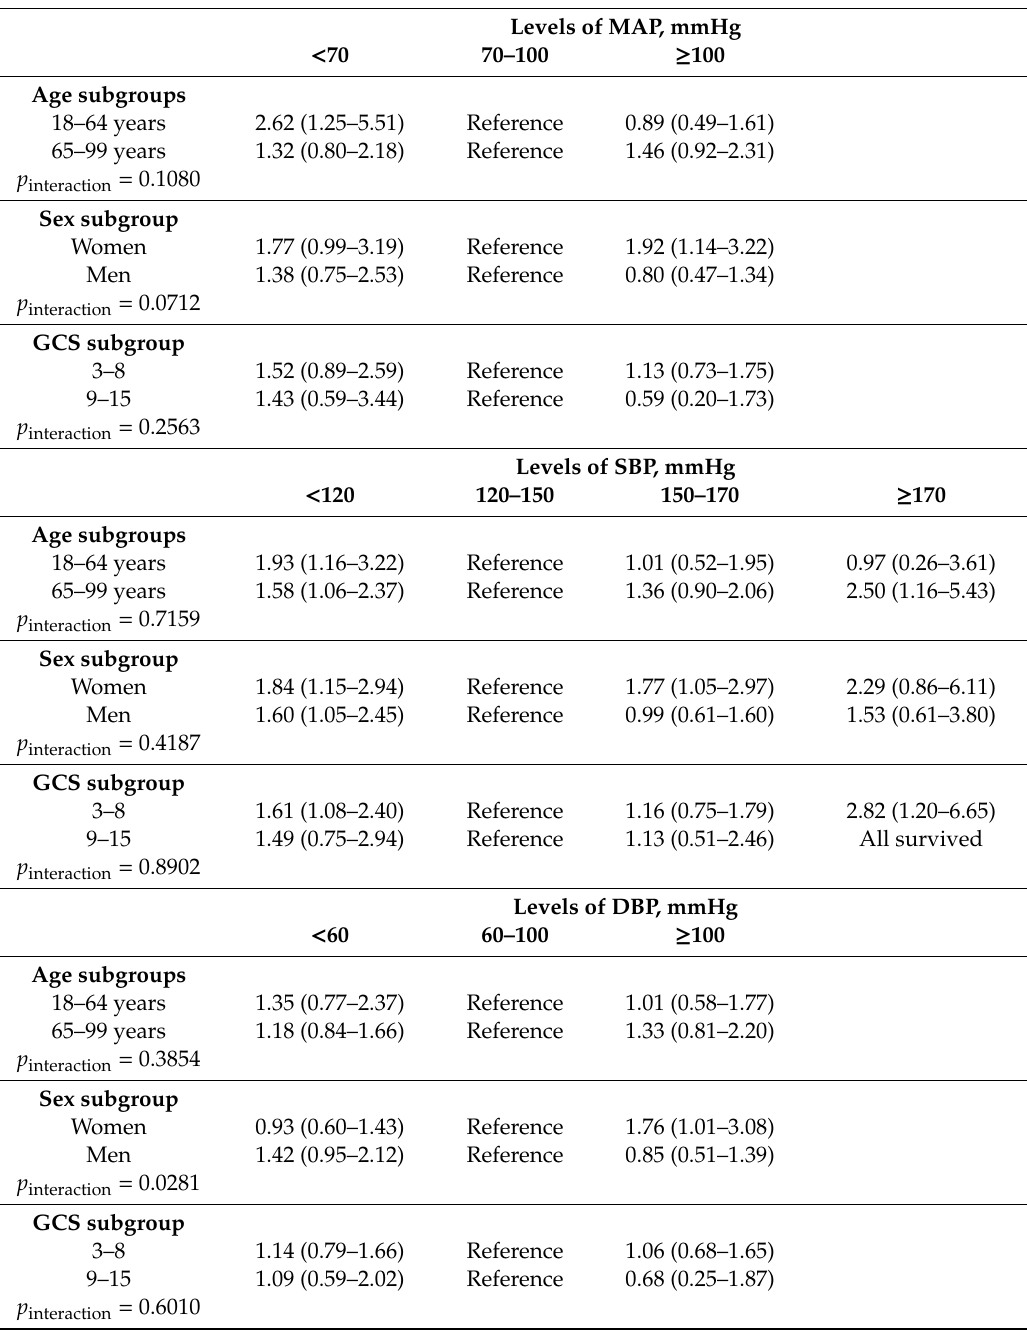
Table 3. Results of stratified analysis for adjusted odds ratio of 14-day mortality in ICU patients with non-traumatic hemorrhage estimated by their MAP, SBP, and DBP